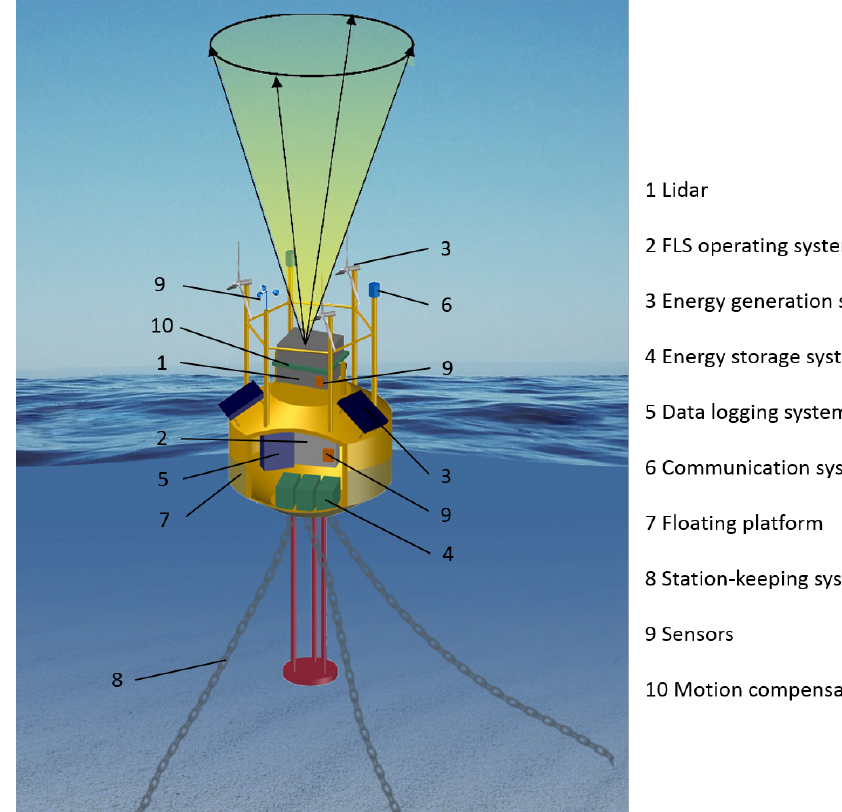
Figure 2. Schematic drawing of an FLS and its components